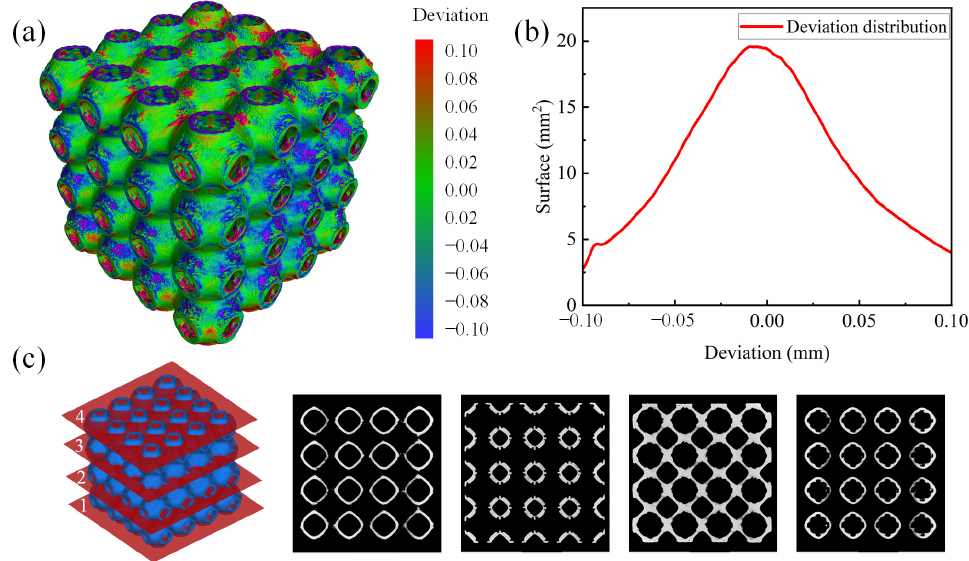
Figure 6. The evaluation of the fabricated samples of P0.6C1 with micro ‐ CT images. ( a ) The 3D deviation maps; ( b ) distribution of deviations over the surfaces; ( c ) tomographic slices of the CT models.